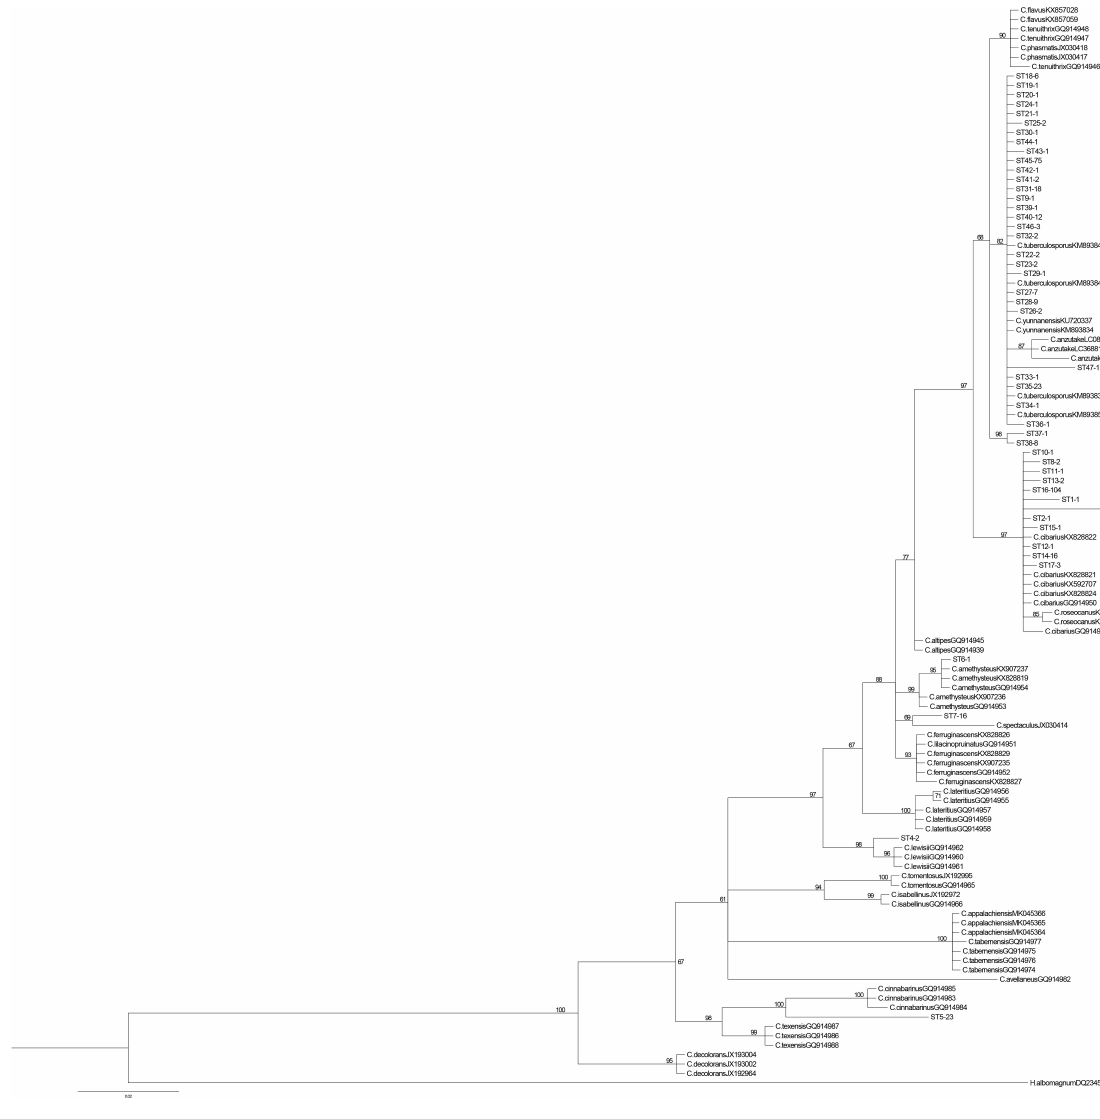
FIGURE 2 | tef-1 phylogenetic tree of the C. cibarius species complex. For each tef-1 sequence type (ST) in our samples, the name or abbreviation (full name can be found in Supplementary Table 2 ) represents the county/community from where the sample was obtained, the number after represents the ST code assignment; the last number represents the total number of samples belonging to the specific